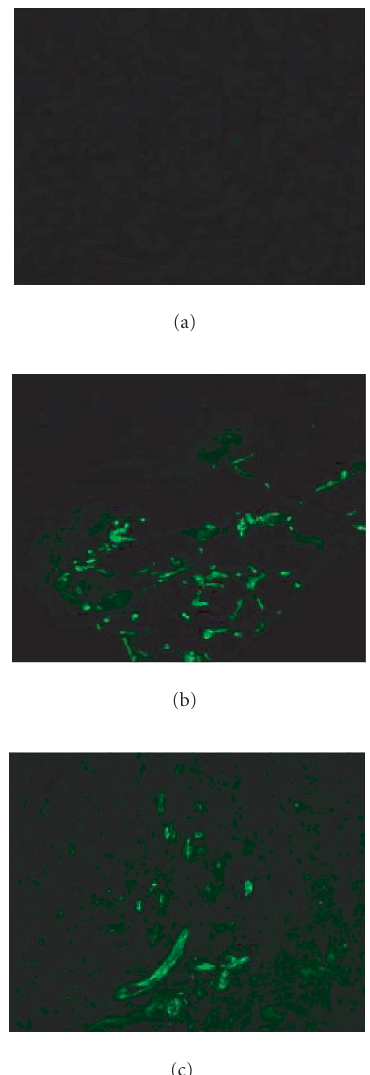
Figure 4. GS IB4 lectin binding in human neurofibroma implanted into SCID mouse. Sections from formalin-fixed, para ffi n-embedded tissues from original tumors and from hu- man neurofibroma xenografts were incubated with fluorescein- conjugated IB4. Slides were examined using an epifluorescent microscope. Fluorescence indicates binding of lectin to Gal α 1- 3Gal on blood vessel cells of nonprimates. Original human tumor (a) does not show fluorescence. Human neurofibroma xenotransplant from nontreated animal (b) and human neu- rofibroma xenotransplant from animal treated with pirfenidone for 6 weeks (c) show fluorescence suggesting that vessels were of host origin since they bound GS IB4. The host origin of blood vessels was not changed in response to therapy with